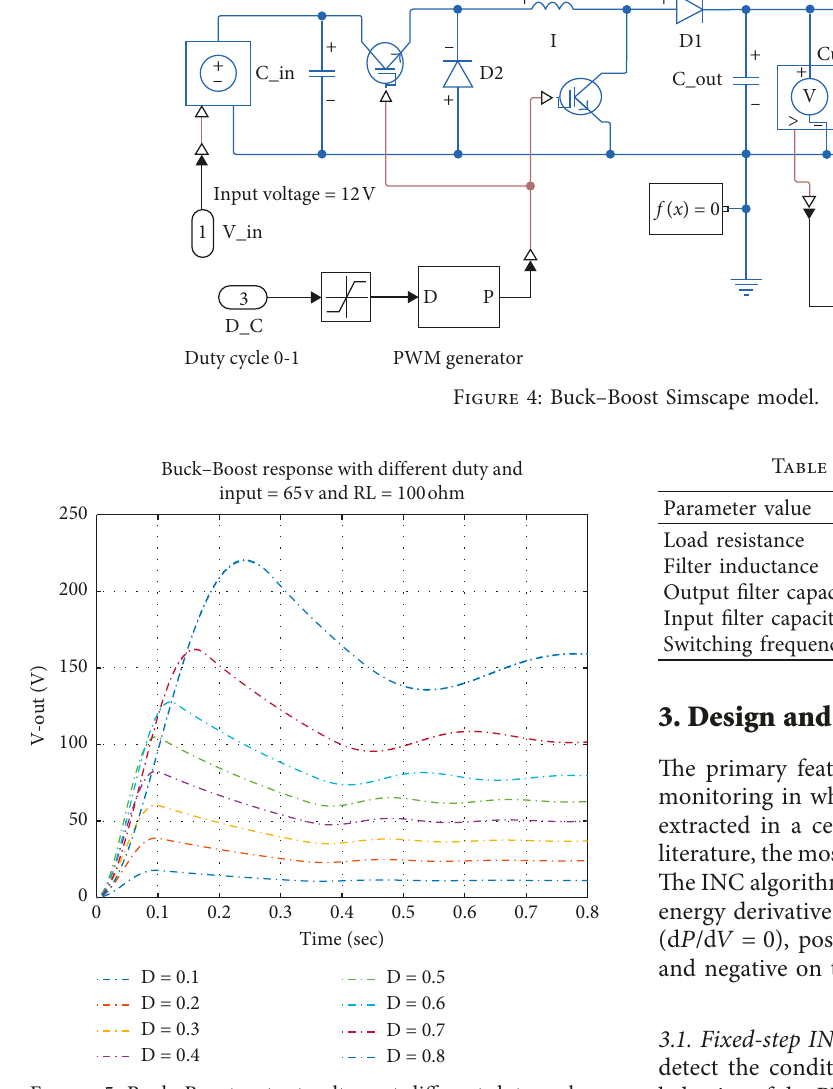
Figure 5: Buck–Boost output voltage at different duty cycles.